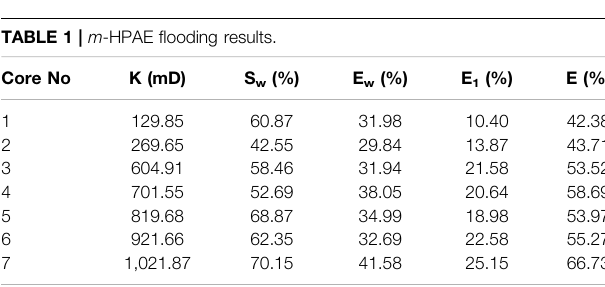
TABLE 1 | m -HPAE fl ooding results.